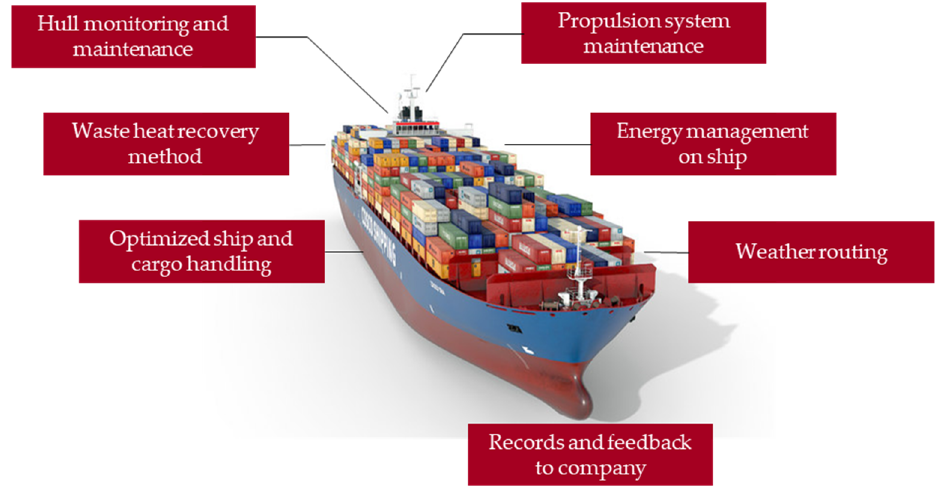
Figure 4. The main key features of SEEMP.